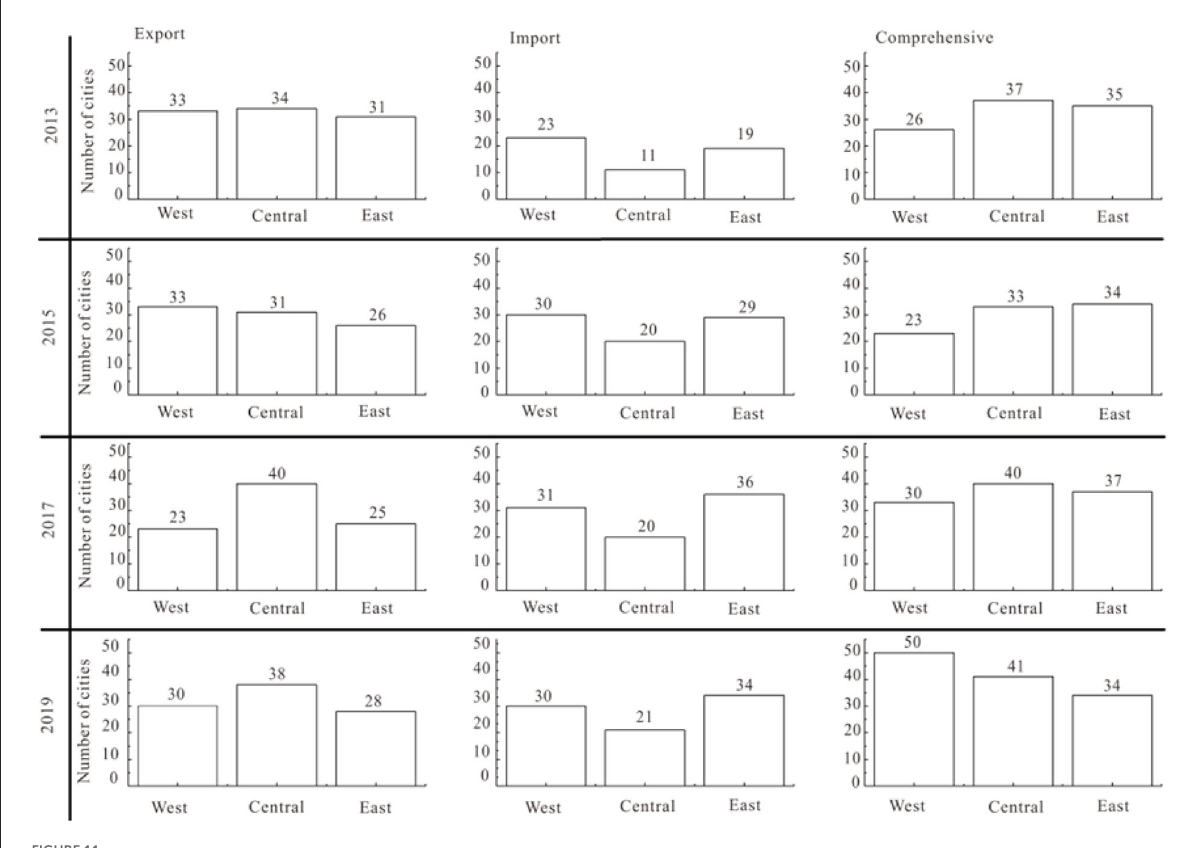
FIGURE11 Types of railway container freight in different cities from 2013 to